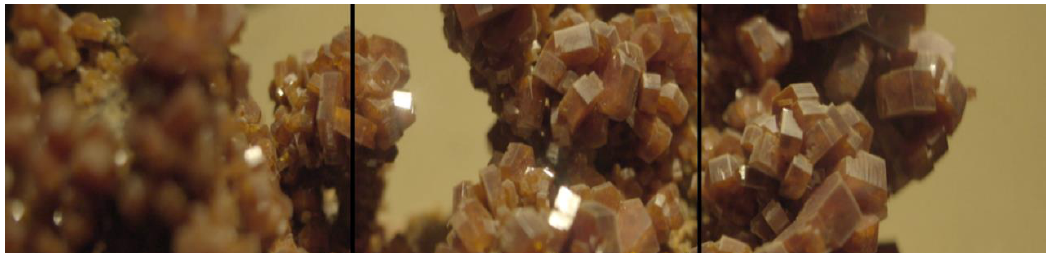
Figure 6. Kerry Tribe, still from The Aphasia Poetry Club (2015), three-channel video with sound, 28:27 min.